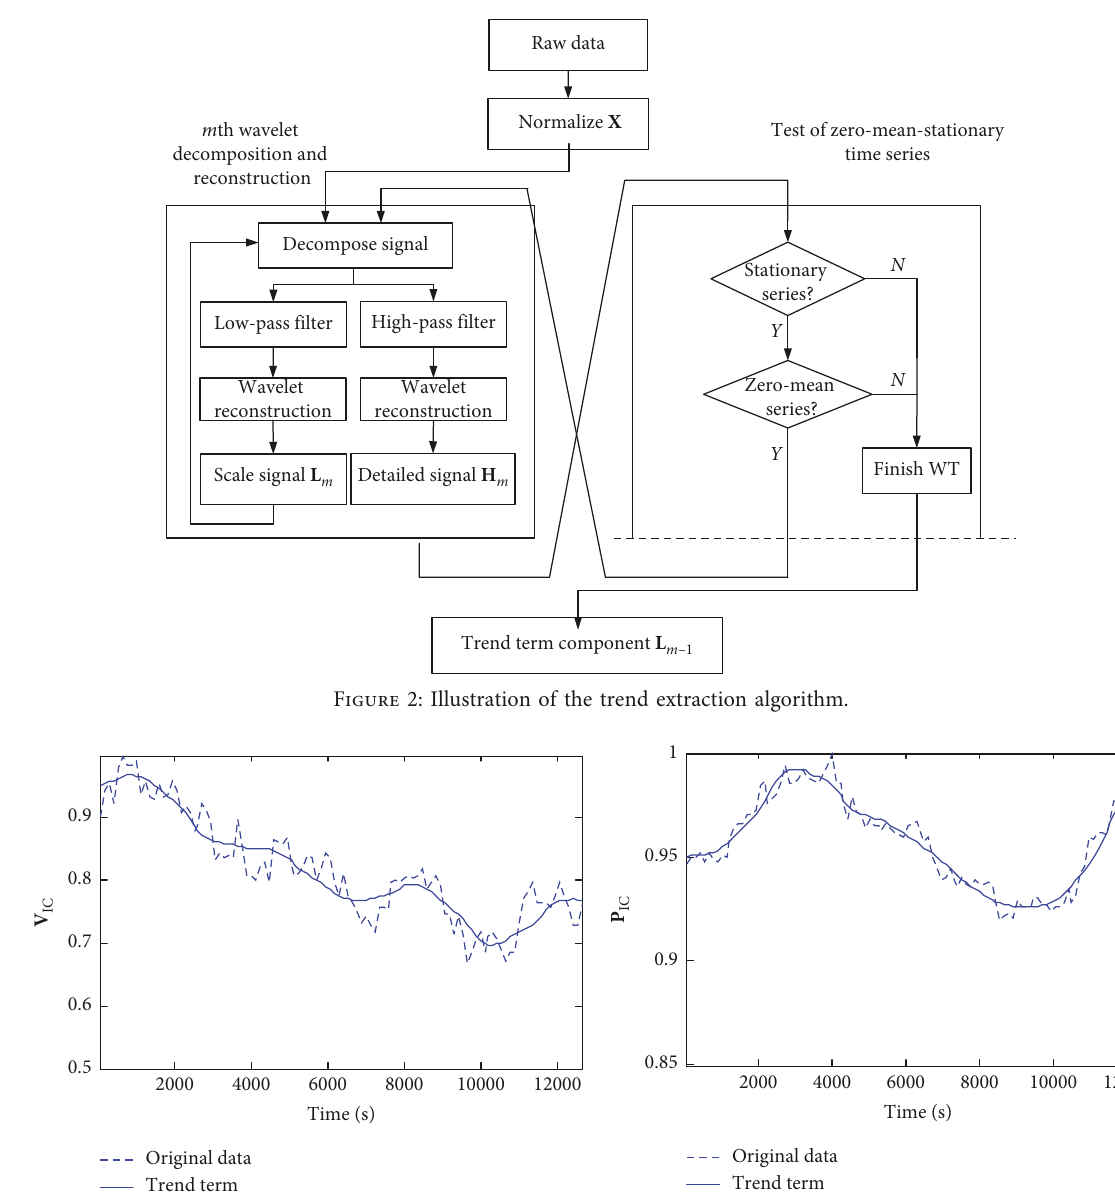
. (b) Time series P IC IC